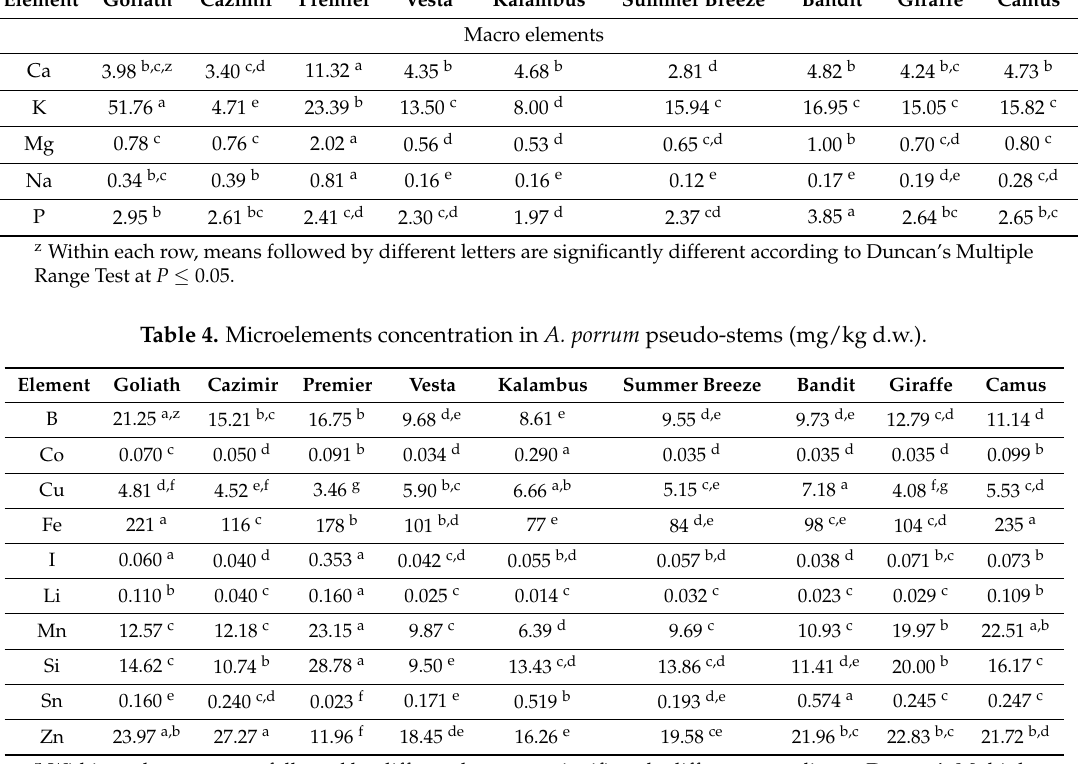
Table 3. Macroelement concentration in A. porrum pseudo-stems (g/kg d.w.). Element Goliath